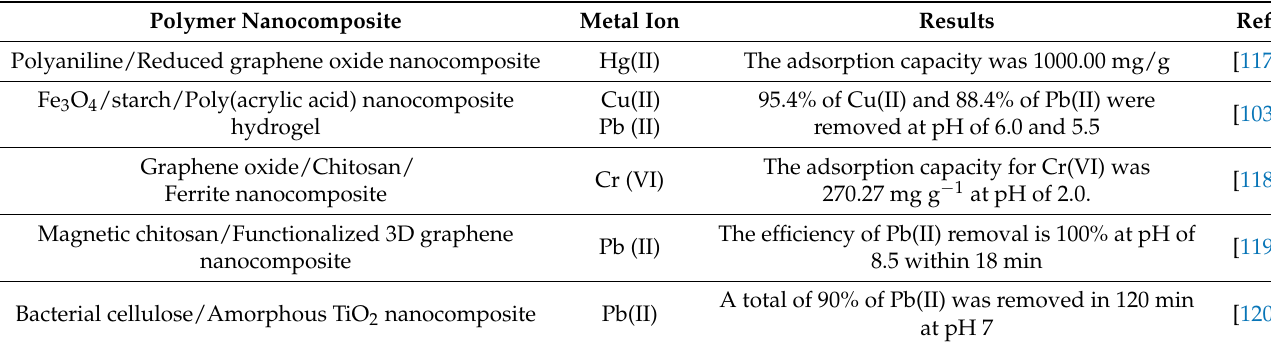
Table 2. Performance of some polymer nanocomposites in metal ion